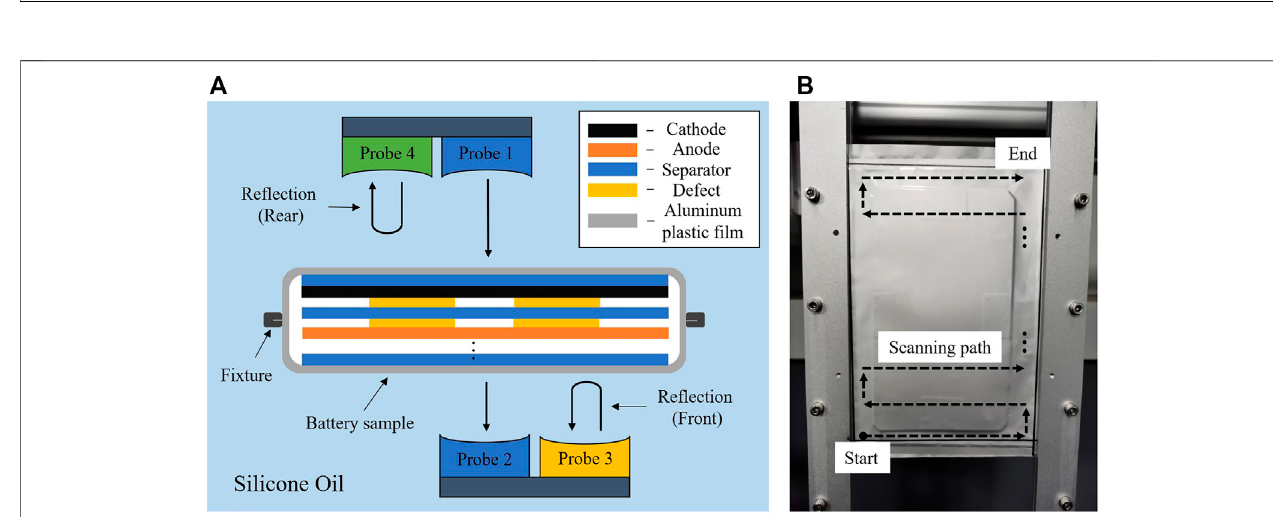
FIGURE 4 | Non-contact NDT methodology for defective